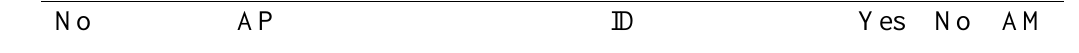
TABLE 1 . Teacher Observation Research